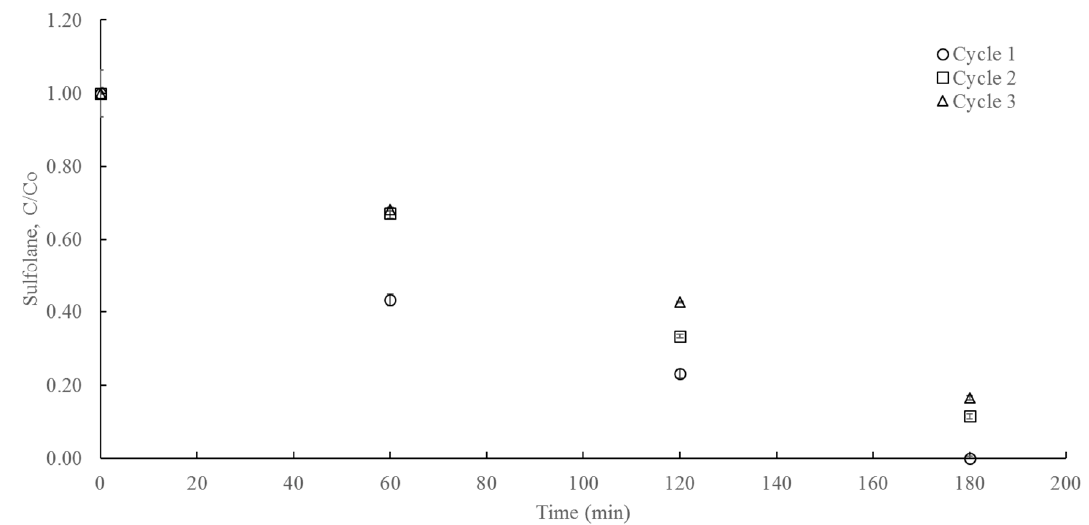
Figure 5. Photocatalytic degradation of sulfolane by TiO 2 in multiple cycles. Table 2. Sulfolane degradation rate in three photocatalytic cycles.